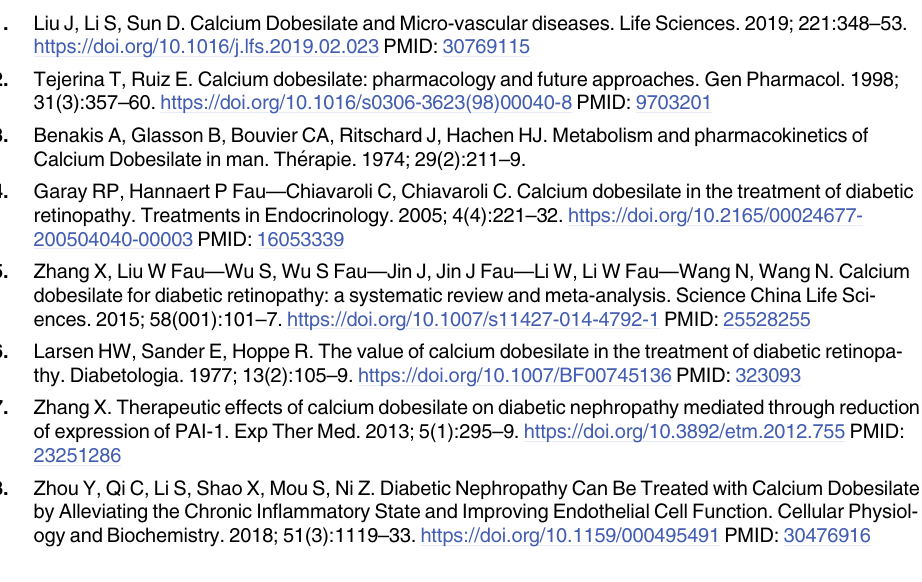
S4 Table. The PK parameters of test preparation in the fed study. S5 Table. The PK parameters of reference preparation in the fed study. S6 Table. The plasma concentration ( μ g/mL) of calcium dobesilate in the fed